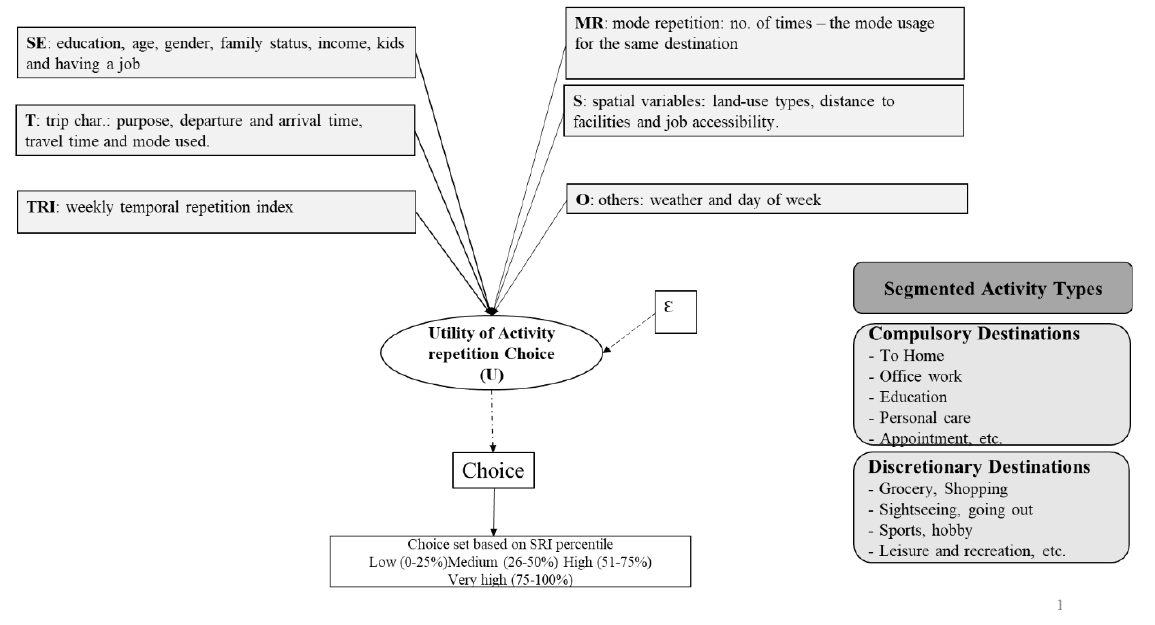
Figure 3. Conceptual model